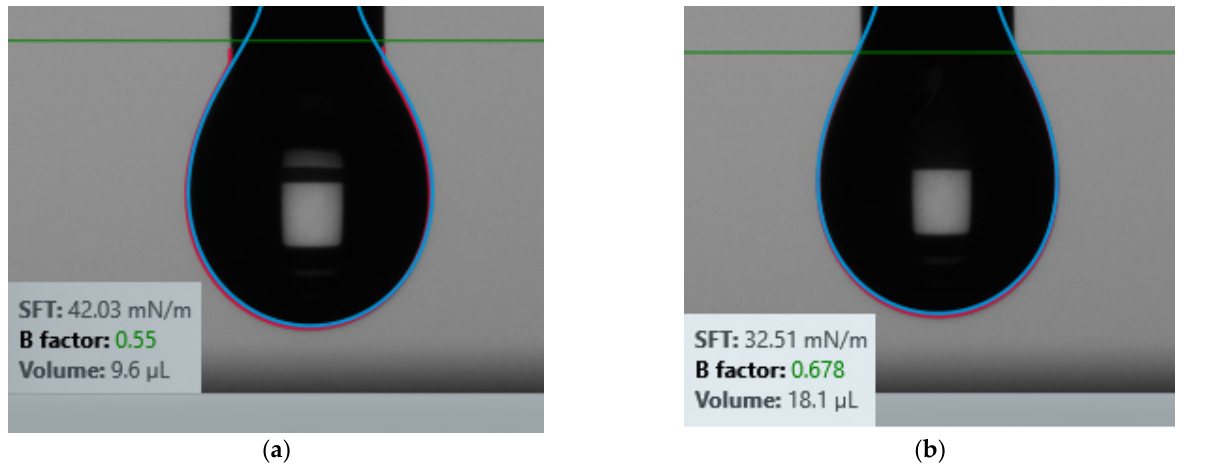
Figure 4. The surface tension of 2.5% PVA on ( a ) Kapton and ( b ) Silicon.